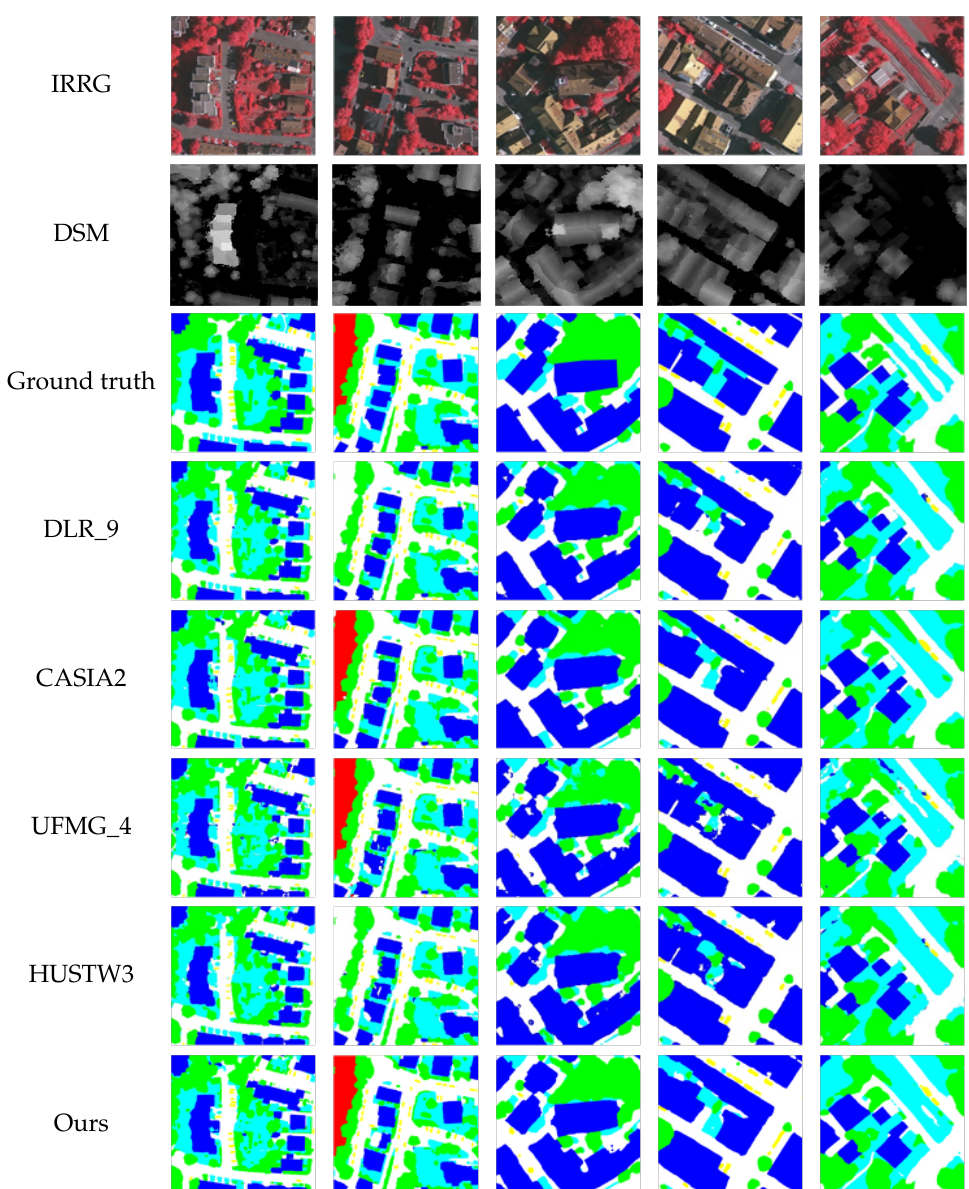
Figure 10. Some samples of the results of the test set on the ISPRS Vaihingen dataset. The LANet, CGFDN, BAM-UNet-sc, MACANet, LRDNet, DGCRNet, and SAGNN currently have no published code and complete test set prediction results